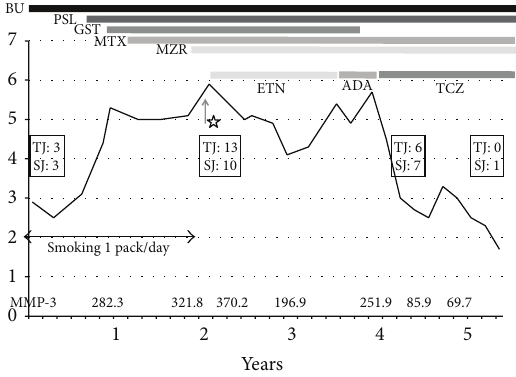
Figure 2: Summary of the clinical course of case 2. DAS28- CRP Disease Activity Score assessing 28 joints with C-reactive protein. BU: bucillamine, PSL: prednisolone, GST: gold sodium thiomalate, MTX: methotrexate, MZR: mizoribine, ETN: etaner- cept, ADA: adalimumab, TCZ: tocilizumab, and MMP-3: matrix metalloproteinase-3. The asterisk shows the cessation of smoking. TJ means tender joint counts and SJ means swollen joints counts for the assessment of DAS 28-CRP.